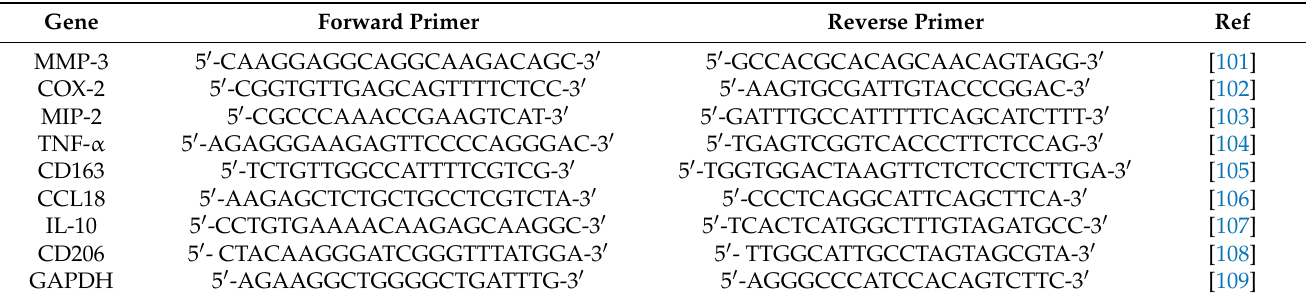
Table 1. Forward and reverse primers for real-time